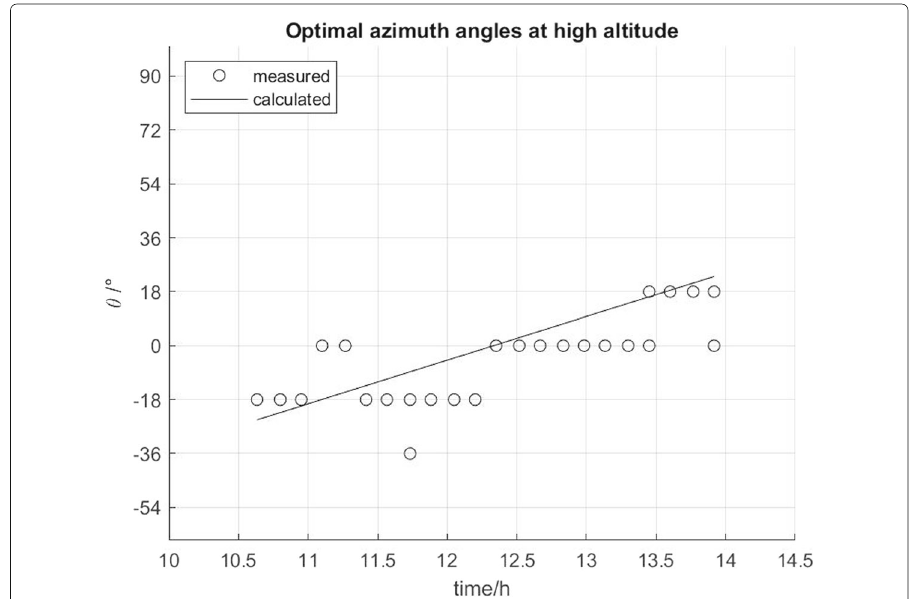
Fig. 10 Optimal azimuth angles at high altitude